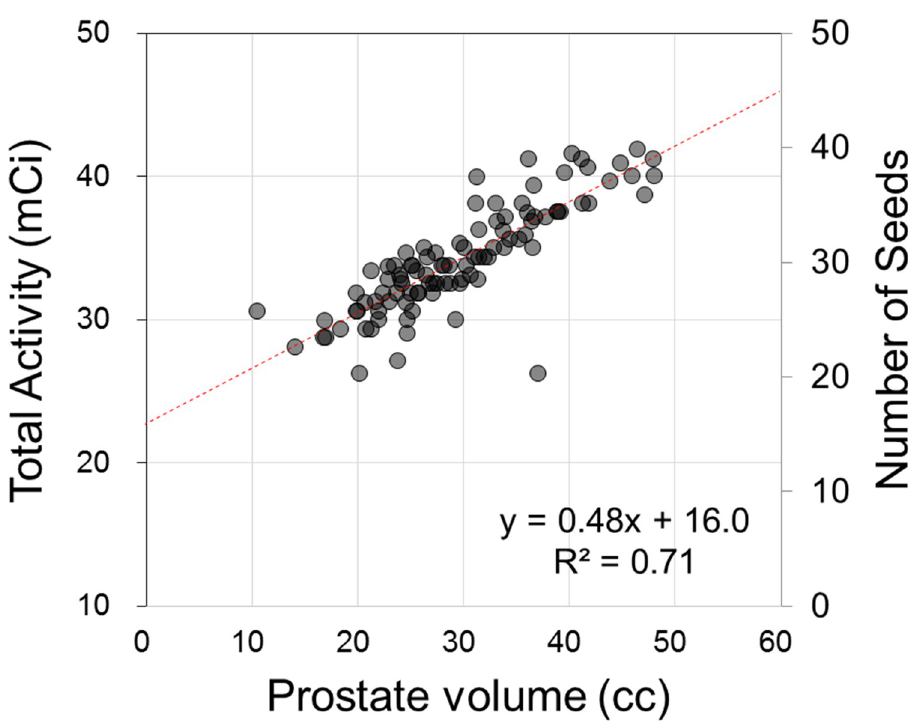
Fig 3. Low-dose-rate brachytherapy nomogram. Data are fitted to a linear expression. In most cases, the total activity or number of seeds is proportional to the prostate volume.